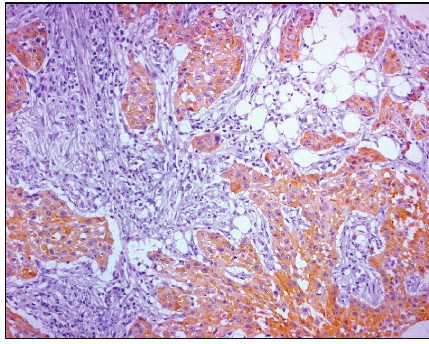
Figure 4: An example of ATC: transferrin is diffusely and strongly expressed in the cytoplasm of neoplastic